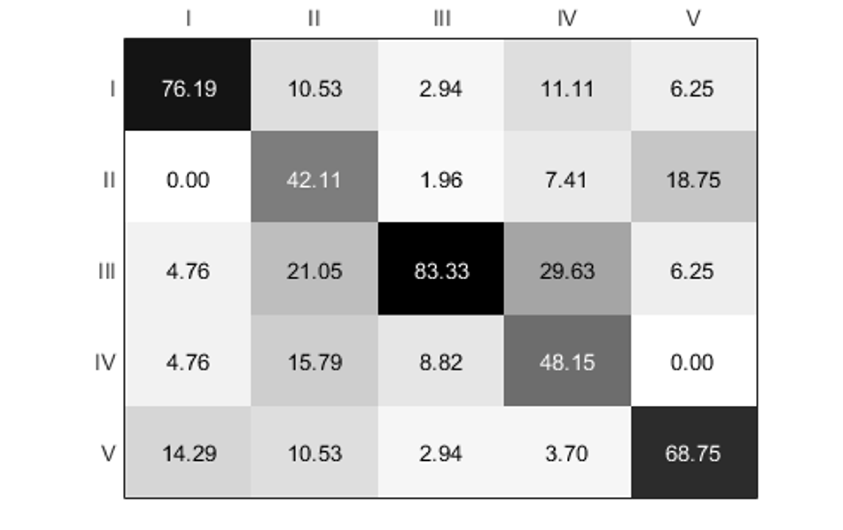
Figure 4. Confusion matrix of the proposed classes I–V on the CASME II dataset using the LBP-TOP feature and SMO as a